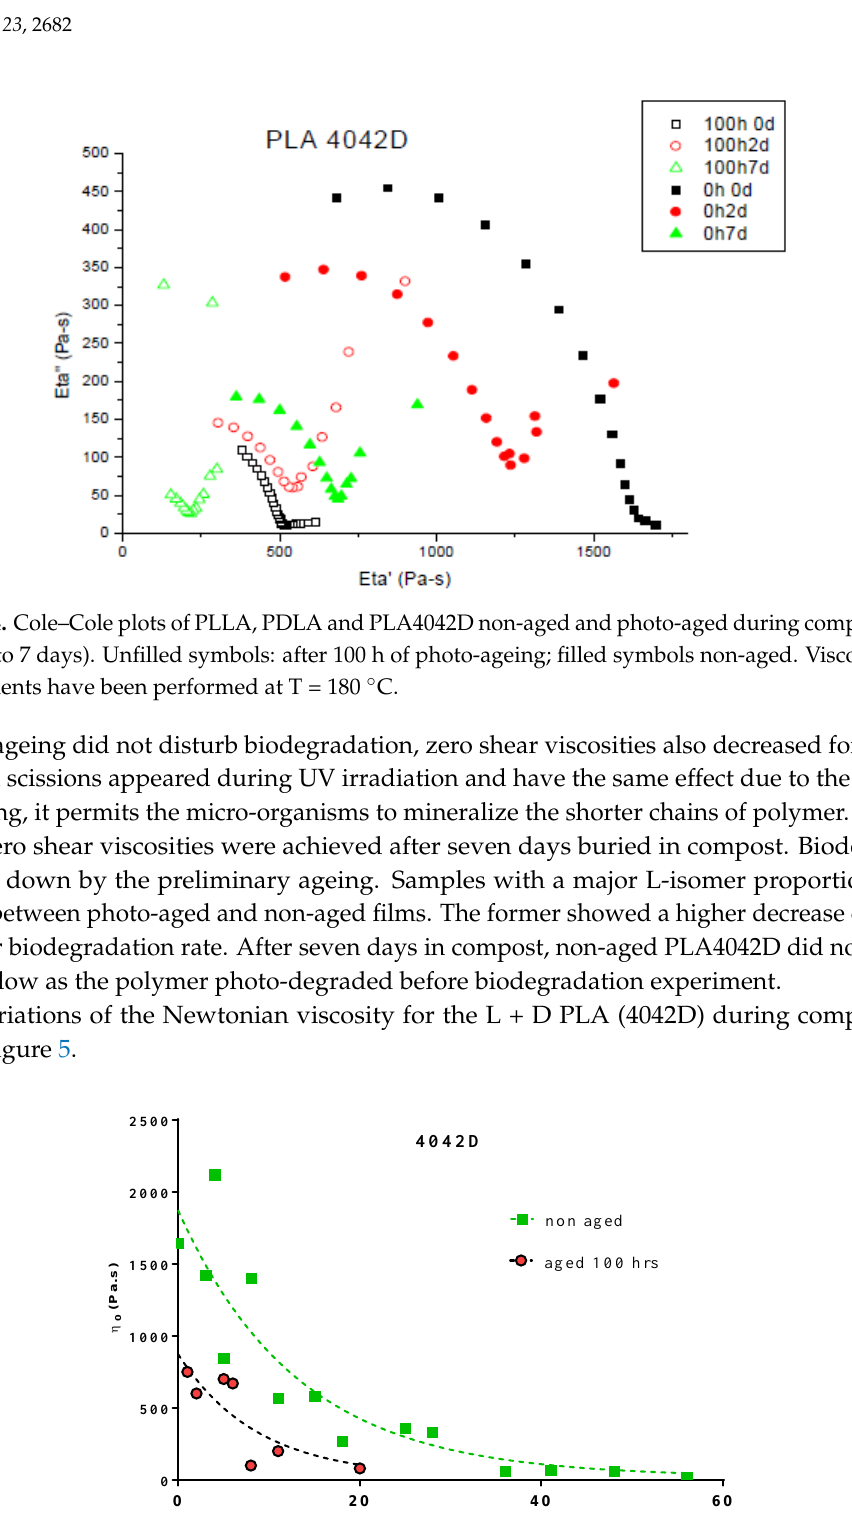
Figure 5. Variation of the Newtonian viscosity versus time of composting for PLA 4042D, 100 h UV aged and non-aged.